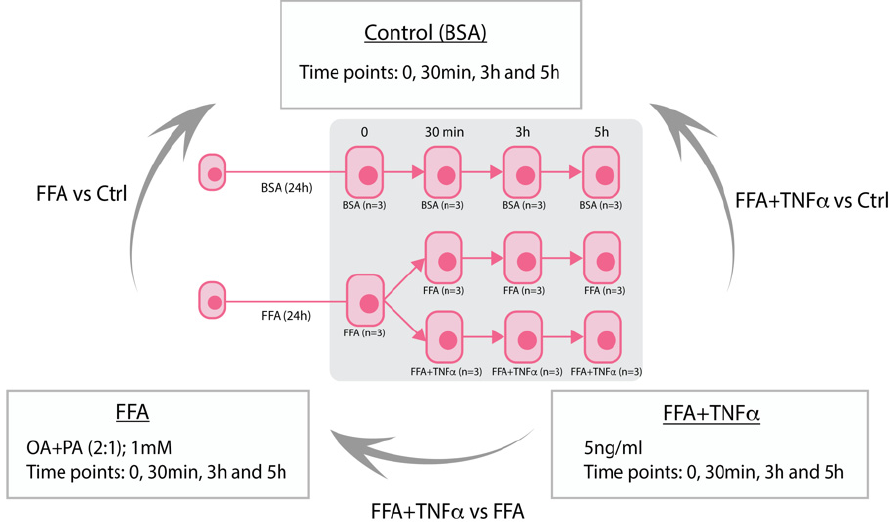
Figure 1. Study overview of HepG2 stimulation. Stimulation of HepG2 hepatocytes with free fatty acids (FFA) to mimic liver steatosis and tumor necrosis factor alpha (TNF α ) to mimic liver inflammation in NASH. BSA (Bovine Serum Albu-